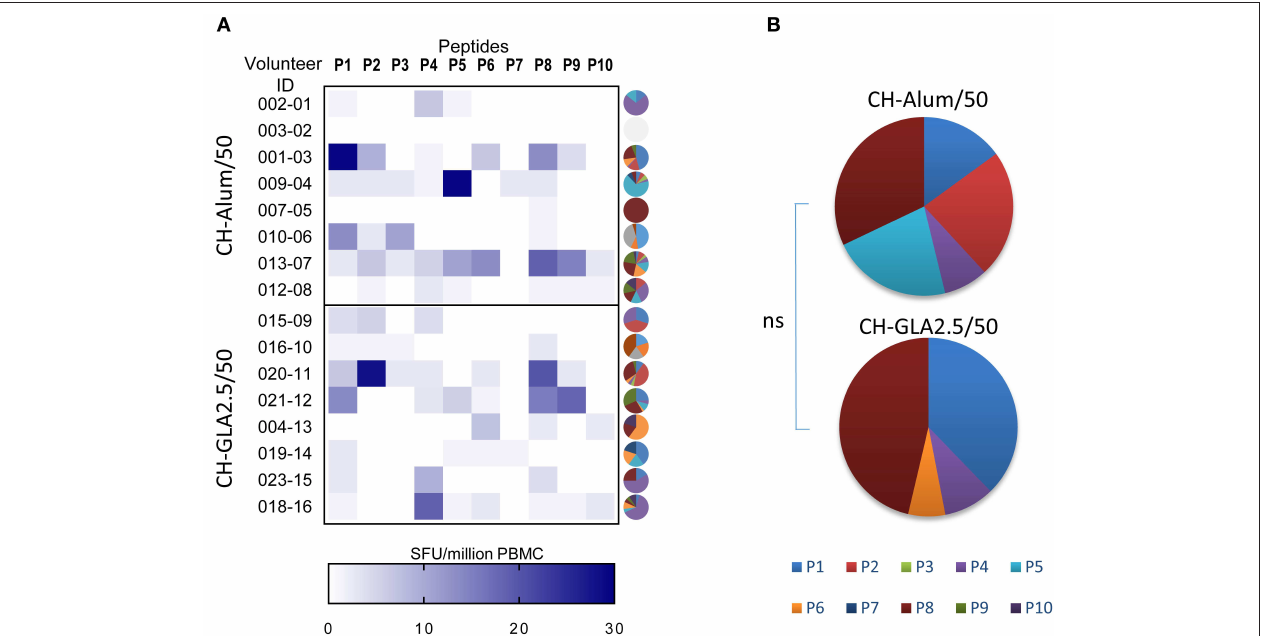
FIGURE 2 | Repartition of the cellular recognition along the sequence of P27A at D84 in Phase 1a. PBMC from unexposed volunteers [CH-Alum/50 ( n = 8) and CH-GLA2.5/50 ( n = 8)] at D84 were individually stimulated with overlapping 20-mer peptides P1 to P10, and the frequency of IFN- γ secreting cells revealed by ELISPOT. (A) Heat map indicates the individual responses to each 20-mer peptide,Y-axis represents the volunteer ID and the X-axis represents the frequency of IFN- γ secreting cells as SFU/million PBMC, and individual pies illustrate the repartition of responses to the 20-mers as % of the total response. (B) Pie graphs show the median value per vaccination group of the percentage of IFN- γ secreting cells to each 20-mer